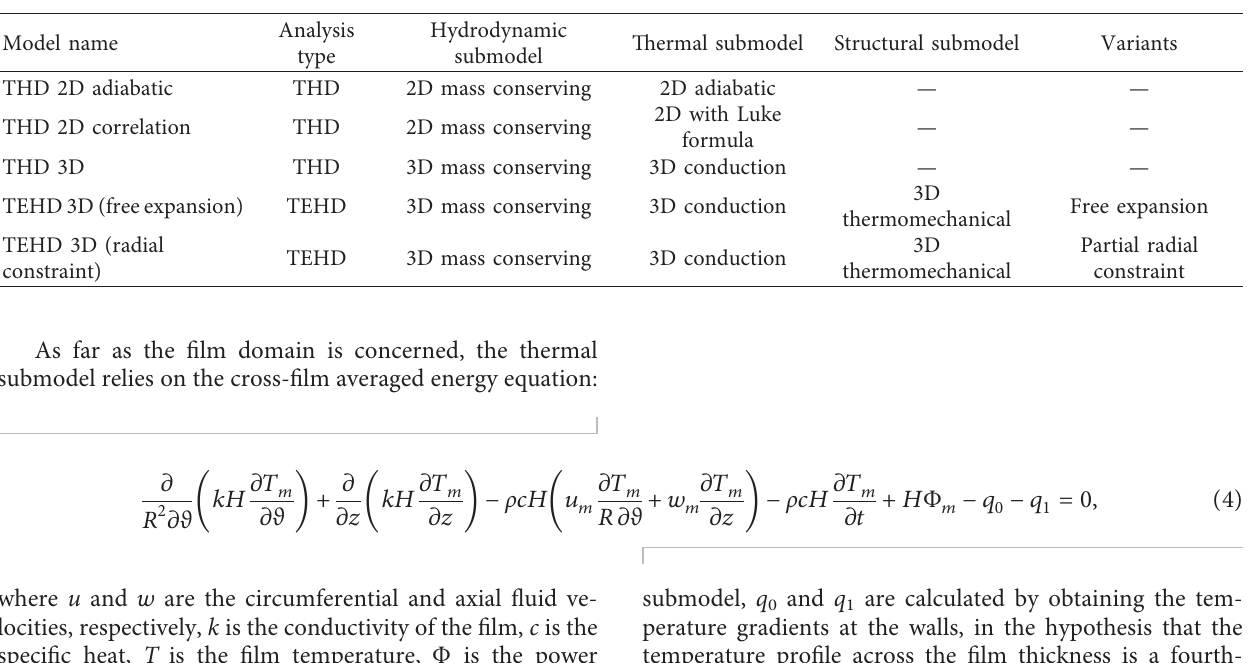
Table 2: Simulation models and